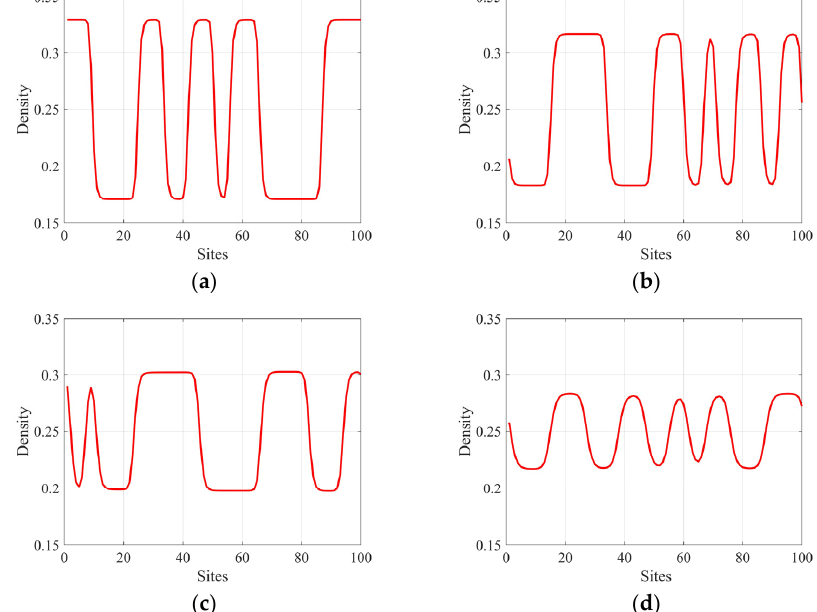
Figure 3. The density profile at t = 3000 s under the different values of ξ . ( a ) ξ = 0, ( b ) ξ = 0.1, ( c ) ξ = 0.2, ( d ) ξ = 0.3.